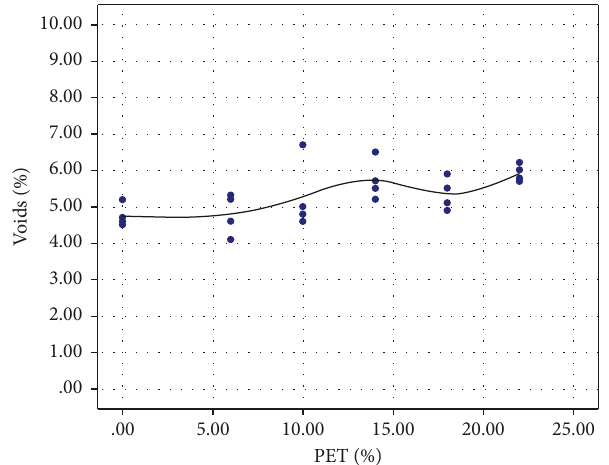
Figure 8: Air voids percentage obtained in the asphalt mixtures.